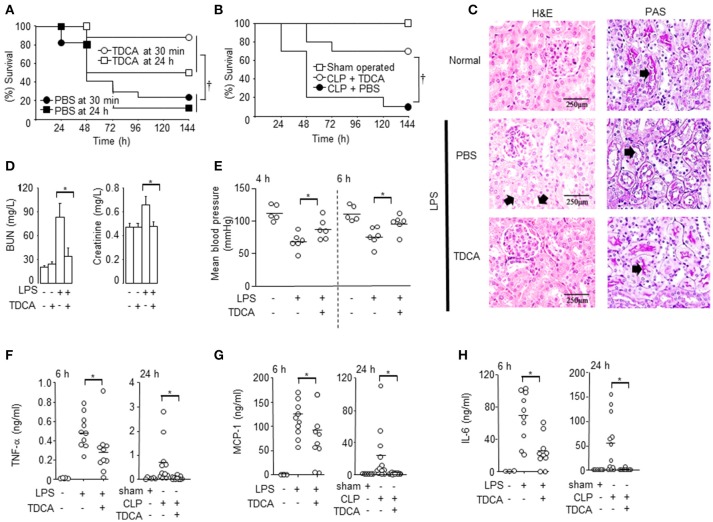
Protection of mice with sepsis after TDCA treatment. (A) The survival of mice under sepsis when TDCA or PBS was administered i.v. at 30 min or 24 h after LPS injection. n = 17 for 30 min and n = 8 for 24 h (B) The survival of mice after i.v. infusion of TDCA (°, n = 10) or PBS (•, n = 10) at 2 h after cecal-ligation and puncture. Sham group (□, n = 5). (C) H&E staining (left column) and PAS staining (right column) of kidney from mice with sepsis at 48 h after treatment with TDCA (n = 6) or PBS (n = 5). n = 3 for the normal B6 mice. Red arrows in the left column and right column denote representative vacuolar degeneration and loss of the brush border, respectively. (D) BUN and creatinine levels in the blood were determined at 48 h post- LPS challenge. The data are expressed as the mean ± standard error of the mean (SEM). n = 4, 4, 19, or 16 for the PBS+PBS, PBS+TDCA, LPS+PBS, or LPS+TDCA groups, respectively. (E) Blood pressure at 4 and 6 h post LPS injection. n = 6 but n = 5 in PBS+PBS group (F–H) The cytokine concentrations in the sera were determined using the cytometric bead array at 6 h post LPS injection or 24 h post CLP. Data shown are pooled from 4 independent experiments for LPS-injection setting or 6 independent experiment for CLP setting with 1~3 mice per experiment. The times (“h”) indicate the interval from the LPS injection or the CLP procedure to time point the data were collected throughout the study. Short horizontal lines among the circles indicate the mean values. p < 0.05 using Kaplan-Meier survival analysis and the log-rank test between groups. *p < 0.05 by Student's two-tailed t-test. Data shown are pooled from 3 independent experiments with 1~3 mice per experiment otherwise denoted.